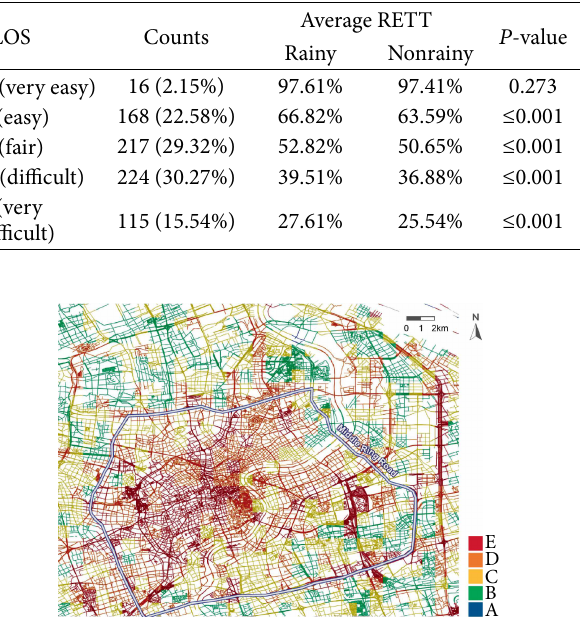
Figure 2: Spatial distribution of regions with difference TLOS on nonrainy days. Regions with TLOS D and E are mainly bounded within the Middle Ring Road, and TLOS B and C are scattered around the